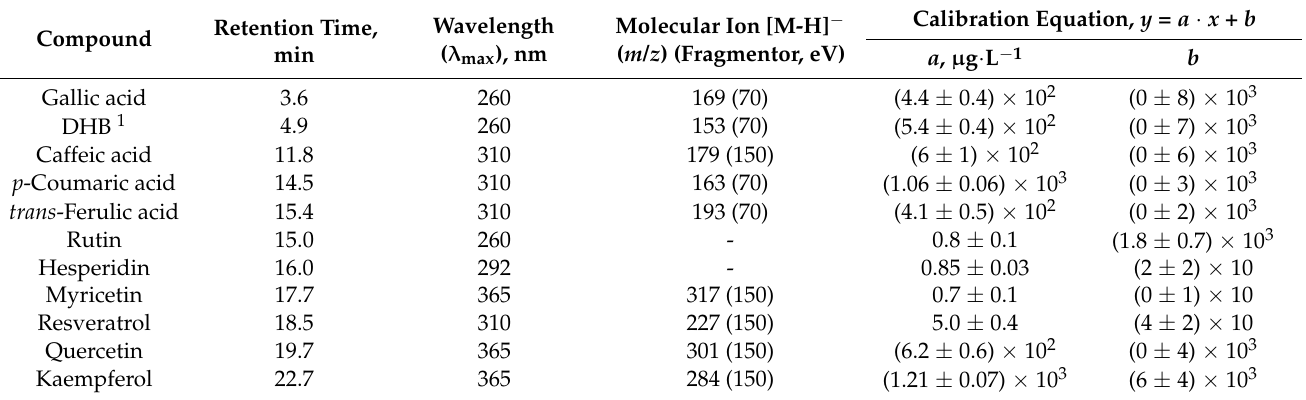
Table 1. cLC-DAD-MS calibration curves, spectral data, and wavelengths for the identification and quantification of